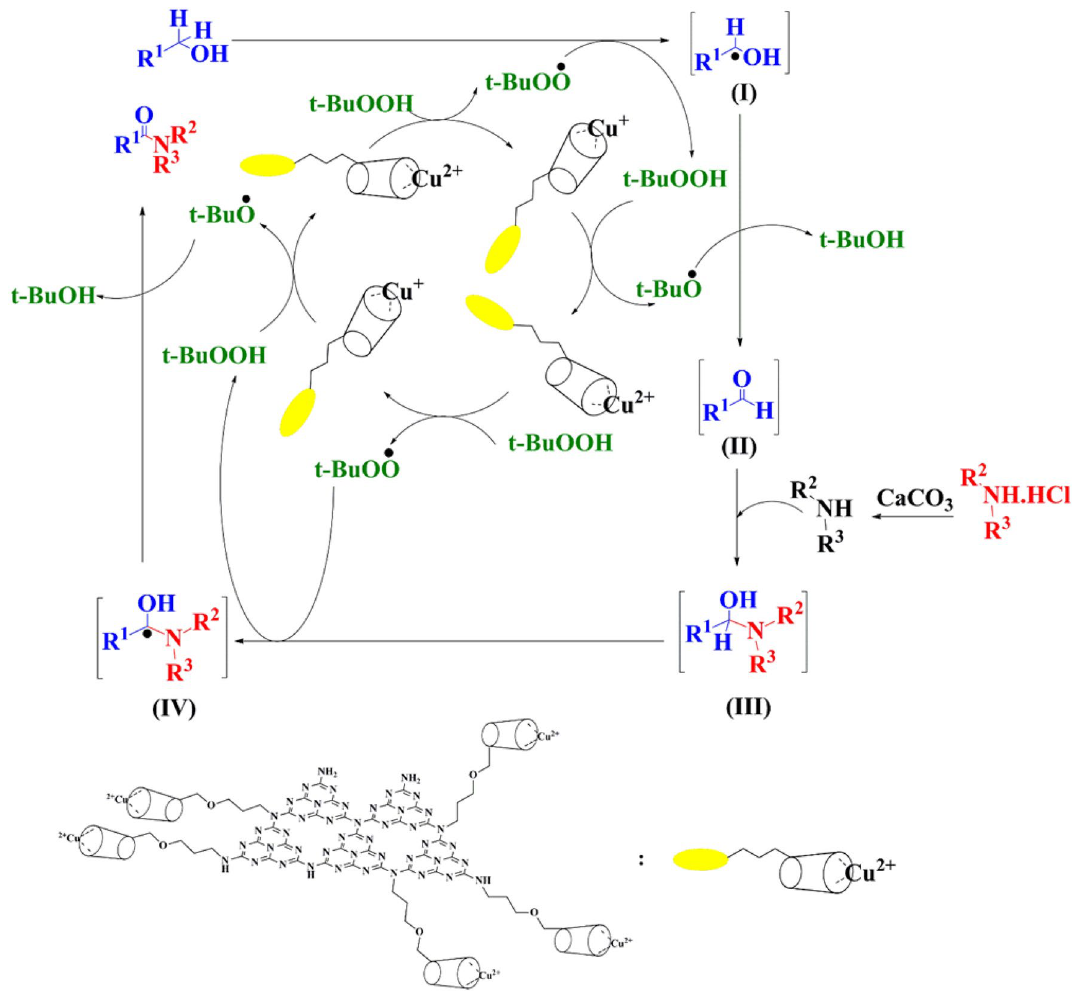
Figure 7. The proposed mechanism for synthesis of amide through the oxidative amidation of benzyl alcohols by CN-Pr-β-CD/Cu(II) catalyst.